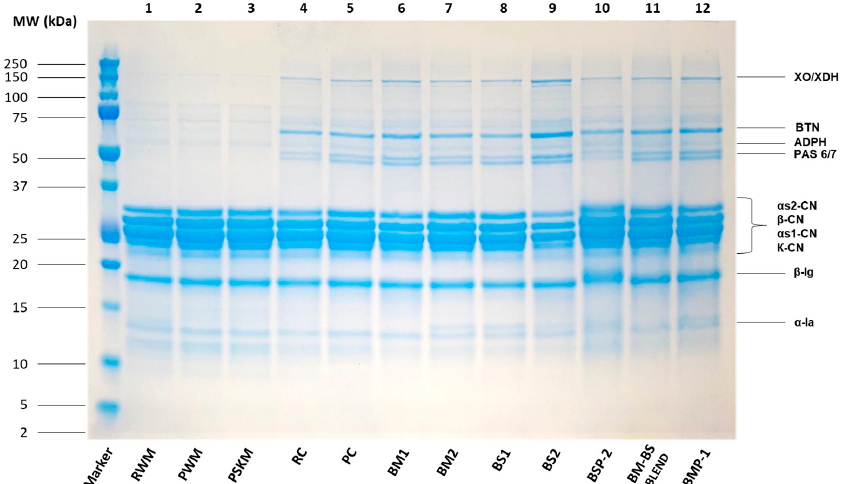
Figure 2. SDS-PAGE protein profile of the milk, cream, and by-product samples of the butter and butter oil manufacturing process. XDH/XO: xanthine dehydrogenase/oxidase, BTN: butyrophilin, ADPH: adipophilin, PAS 6/7: glycosylation variants of lactadherin, CN: casein, lg: lactoglobulin, la: lactalbumin. Markers: left column denotes the molecular weight markers (kDa). RWM: raw whole milk, PWM: